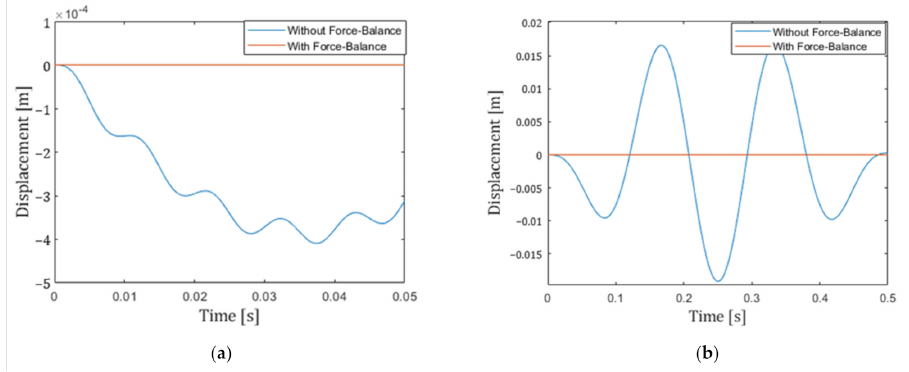
Figure 12. Simulation results of different acceleration input frequencies ( a ) 100 Hz; ( b ) 5 Hz. The x -axis is the time; the y -axis is displacements of the proof mass in different cases. The displacement becomes smaller for the higher frequency due to the small resonance frequency of 0.39